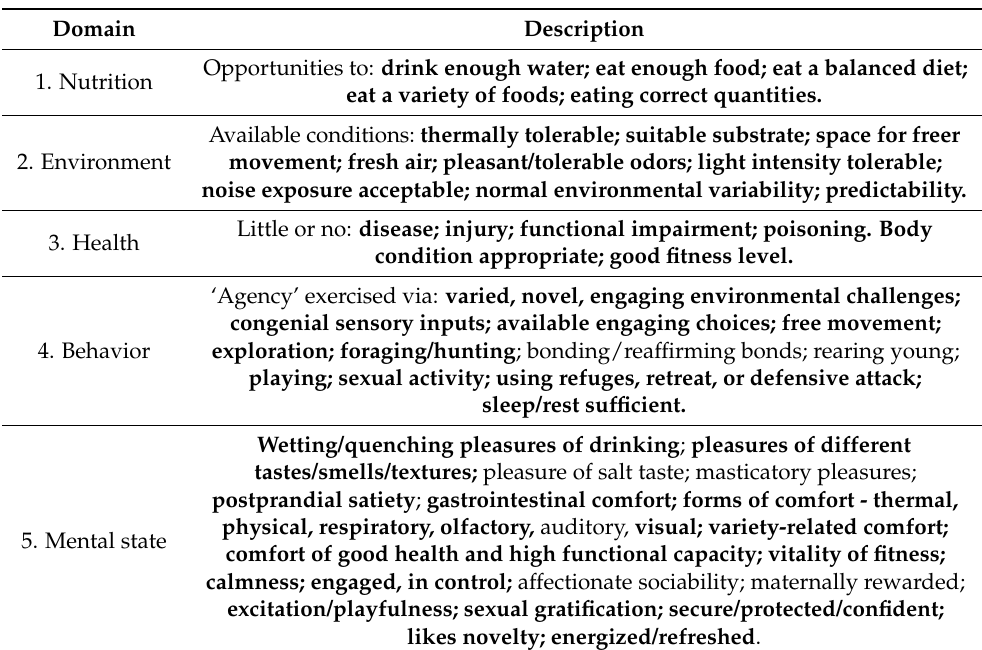
Table 2. Mellor’s [25] Five Domains Model (reduced and summarized) illustrating positive states and animal welfare. Factors highlighted in bold text suggested as notably relevant to snake positive or negative welfare, and improved by greater space or hindered by lesser